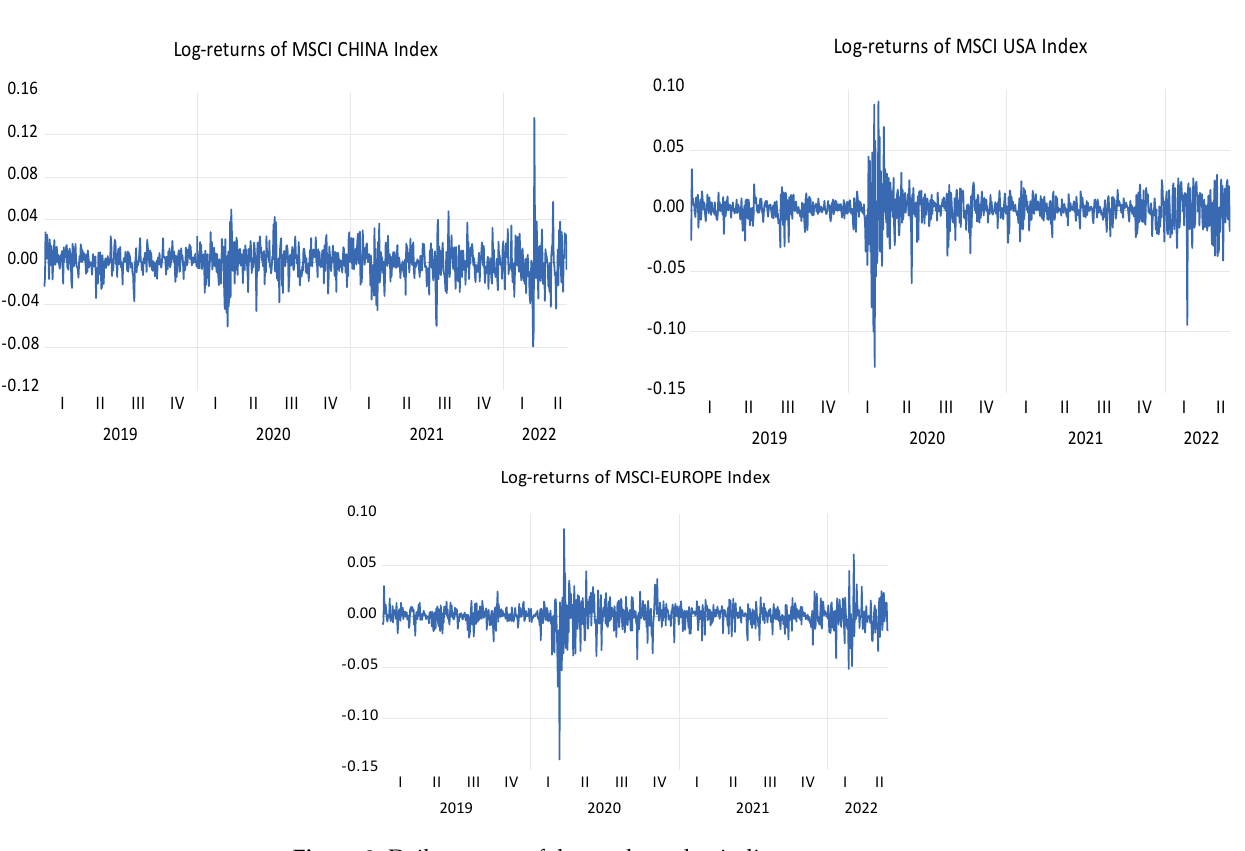
Figure 1. Evolution of the values of the stock market indices.